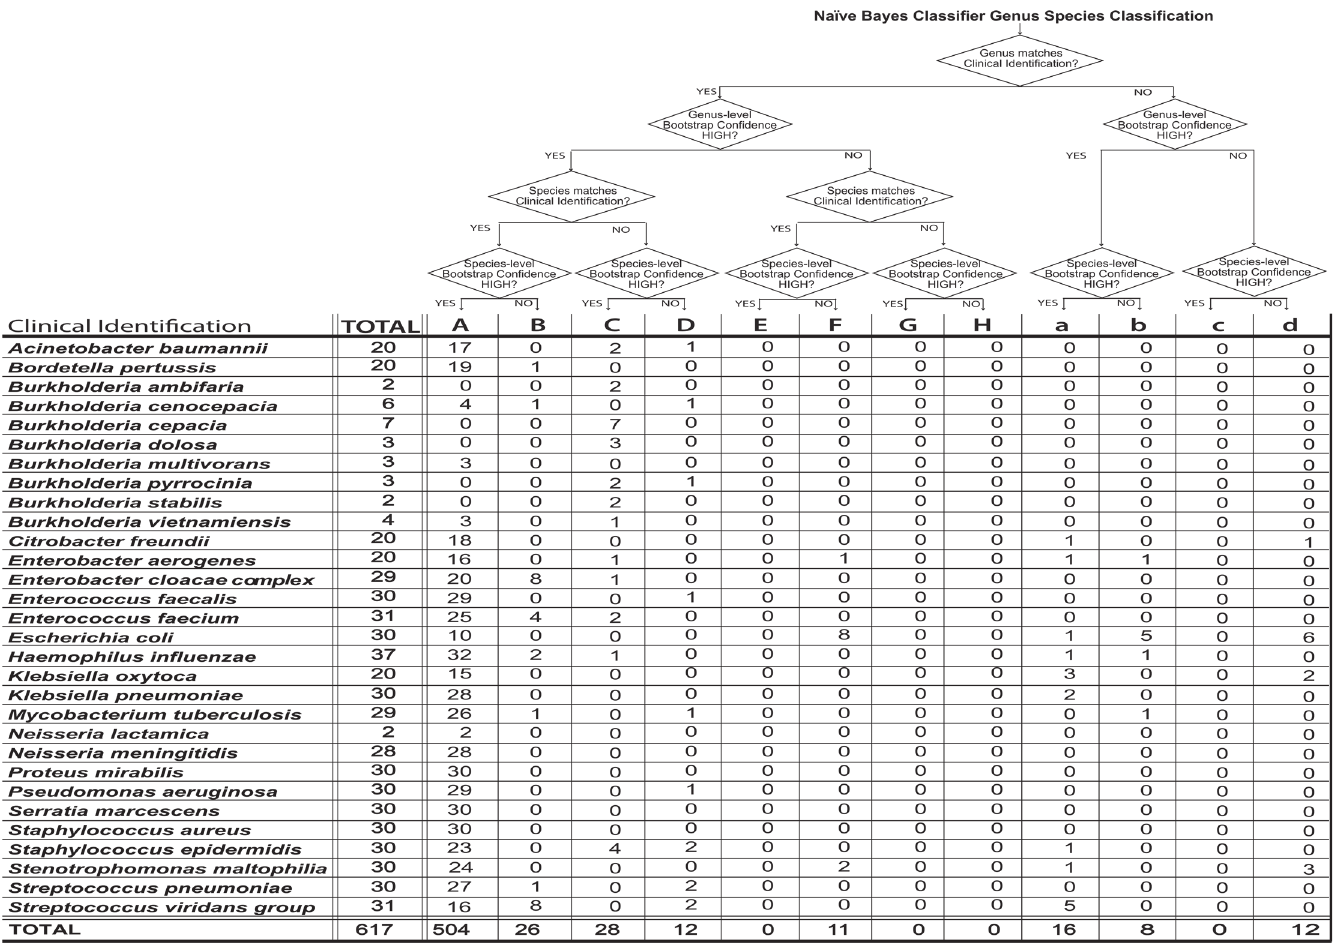
Fig 5. 16S rRNA based genus and species level isolate identities with the Na ï ve Bayes classifier. Each isolate was assigned to one of 12 categories (A-H, a-d) based on the agreement between clinical and 16S rRNA based genus and species classifications and the confidence scores.